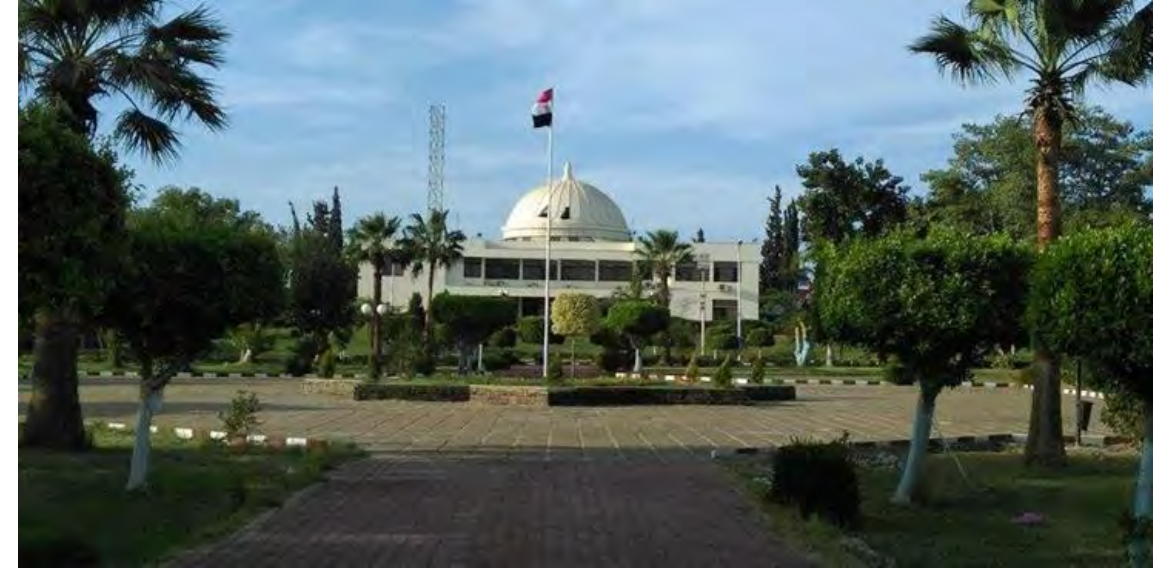
Figure 5. main entrance south elevations